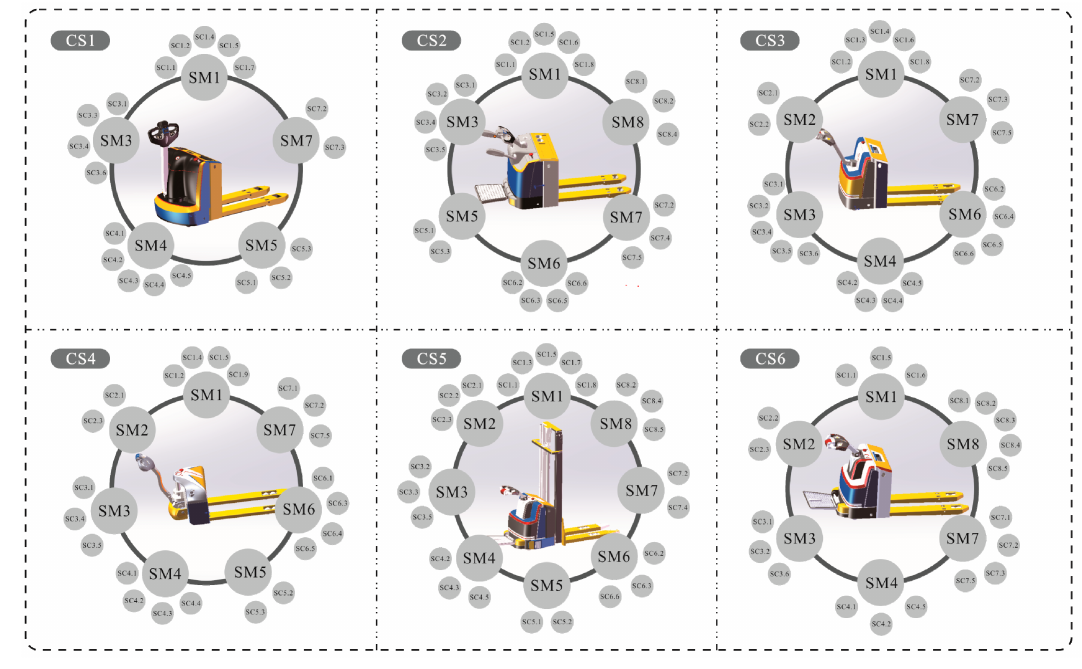
Figure 2. Schematic diagram of the electric forklift PSS